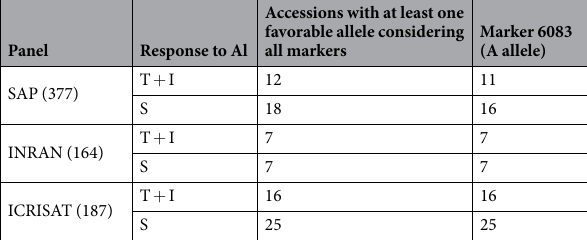
Accessions with at least one favorable allele considering all markers